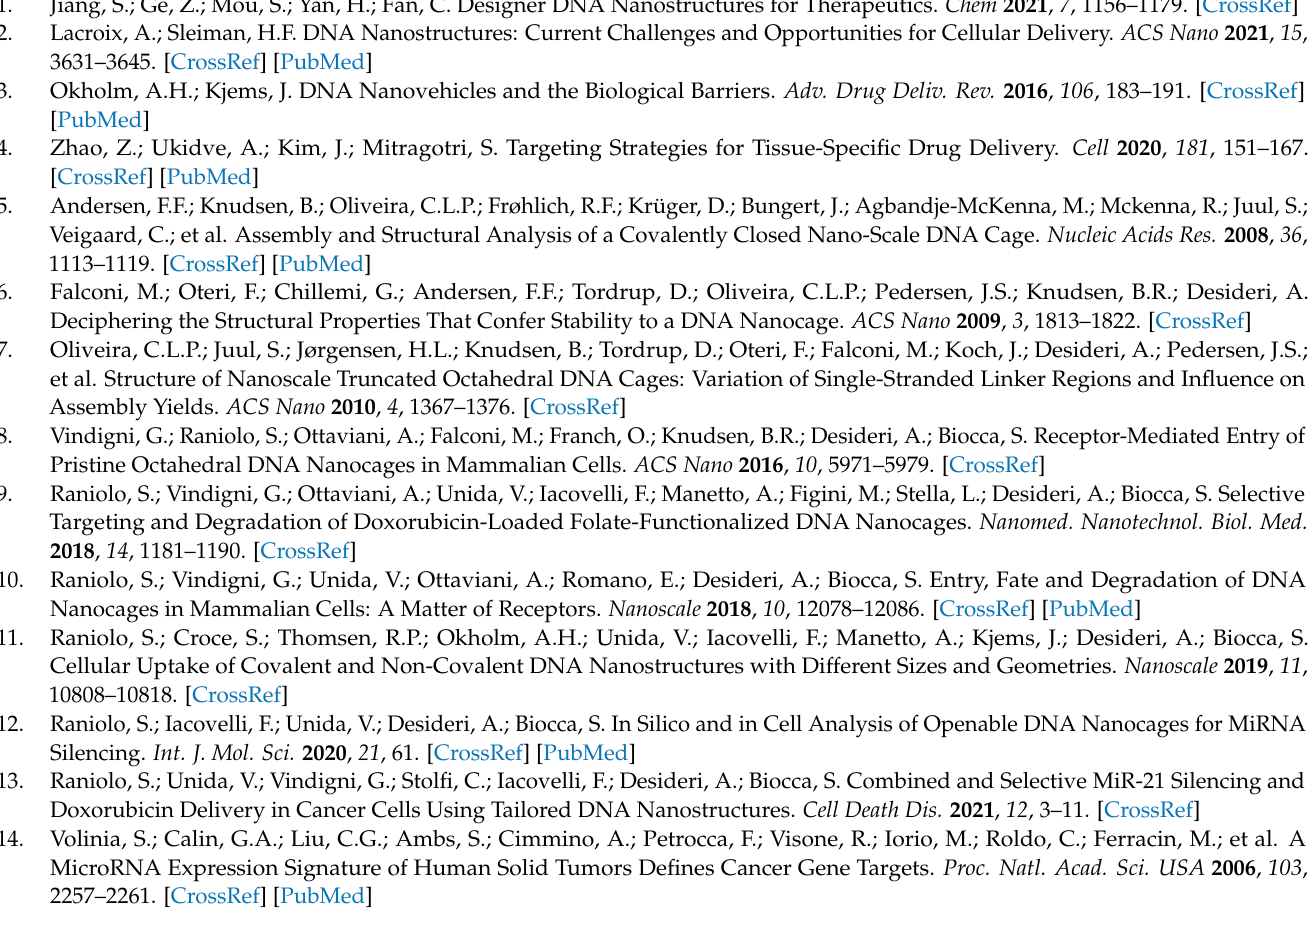
for DNA nanostructures assembly; Figure S1: In vitro anti-miRNA opening reaction; Figure S2: Dose- dependent cytotoxic effect of NC, Fol-NC, Apt-NC, and Fol-Apt-NC on MDA-MB-231 cells; Figure S3: Downstream effect of miR21 knockdown in MDA-MB-231; Figure S4: Standard curve of free Dox fluorescence; Figure S5: Time and dose-dependent cytotoxic effect of free Dox on HeLa and MDA- MB-231 cells; Figure S6: Confocal analysis of Dox-loaded